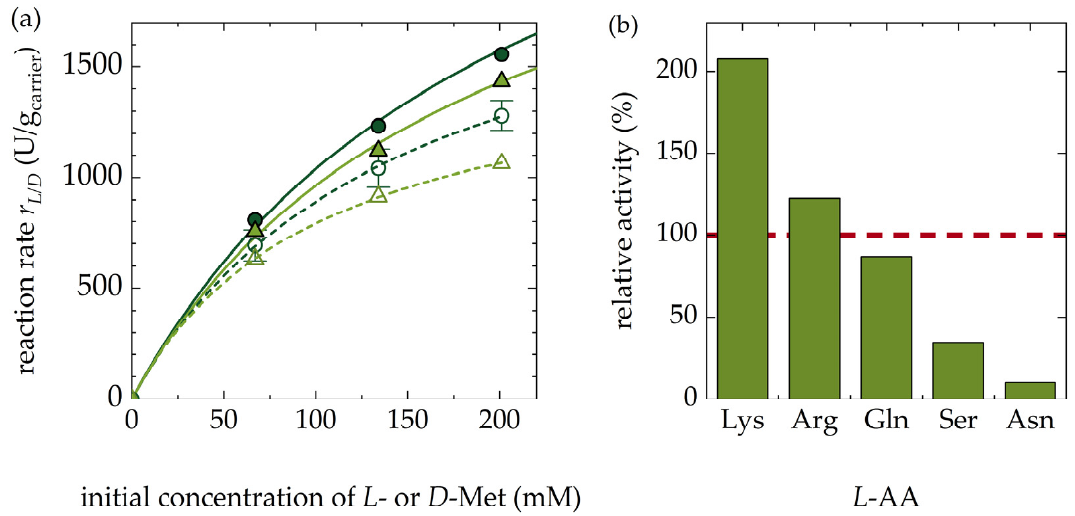
Table 5. Kinetic parameters of immobilized AAR for D -Met of B1 and B2 at 20 °C in pure water, Equation (1).